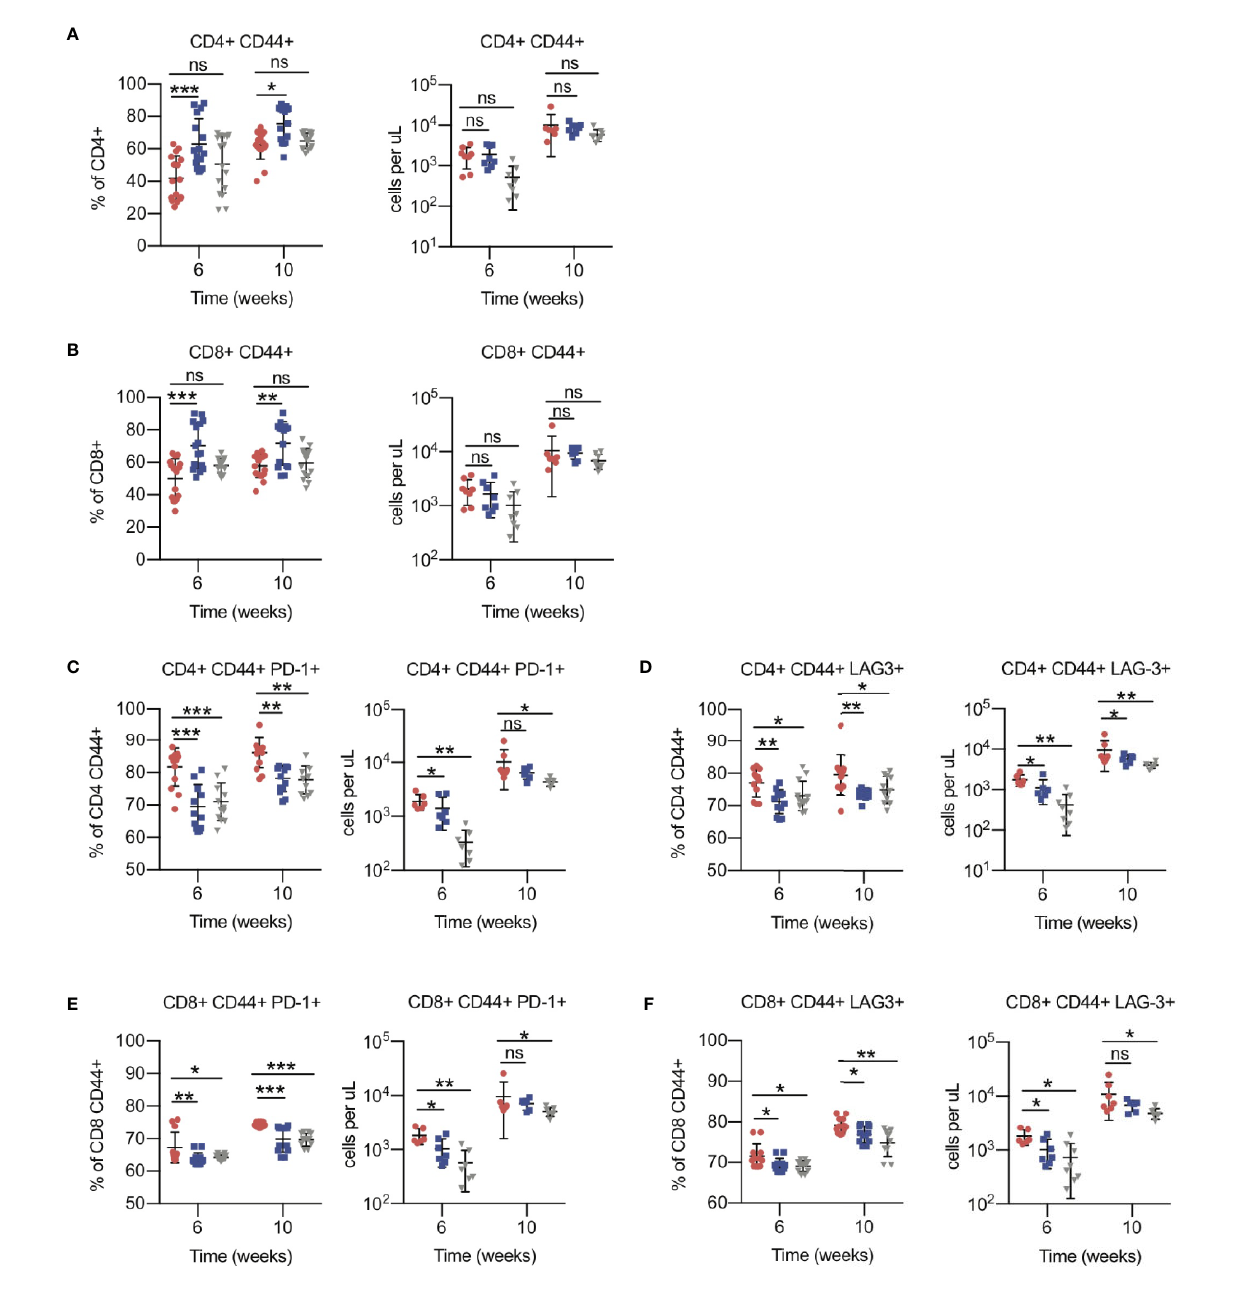
FIGURE 3 | Effects of HDAC6 de fi ciency on antigen-experienced CLL T-cell compartment. (A) Percentages and counts of antigen-experienced CD44 + out of CD4 + gate. (B) Percentages and counts of antigen-experienced CD44 + out of CD8 + gate. (C, D) Percentages and counts of PD-1 + and LAG3 + cells out of CD44 + CD4 + gate. (E, F) Percentages and counts of PD-1 + and LAG3 + cells out of CD44 + CD8 + gate. Percentages are compiled from 2 independent experiments, n = 12 – 14 mice per group. Counts are shown from 1 representative experiment, n = 8 mice per group. Graphs display mean + SD. * p < 0.05, ** p < 0.005, *** p < 0.0005. ns, not signi fi